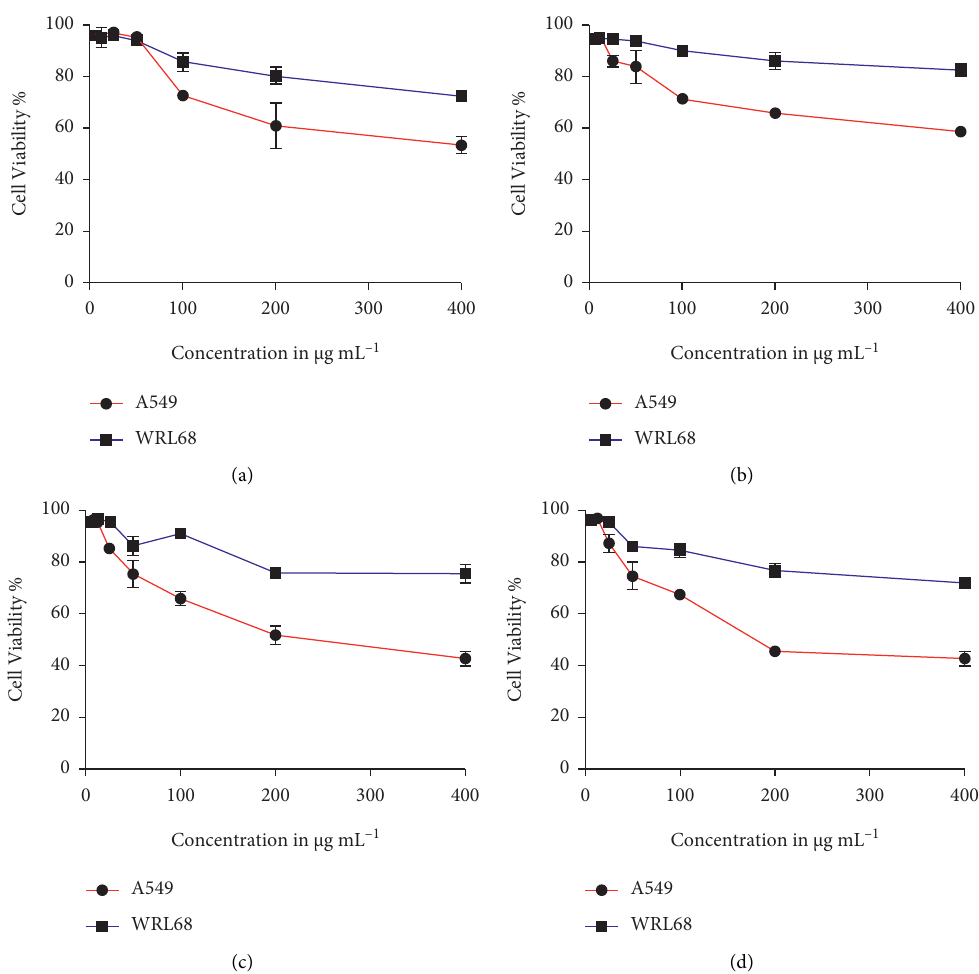
Figure 12: Antiproliferative activity of the NPs against A549 and WRL68cells. (a, b) Cells were treated with the NPs synthesized by 30 mJ/ cm 2 and 60mJ/cm 2 without magnetic field, respectively. (c, d) Cells were treated with the NPs synthesized by 30mJ/cm 2 and 60mJ/cm 2 with the magnetic field, respectively. 100, 200, 300, and 400 µ g mL − 1 were